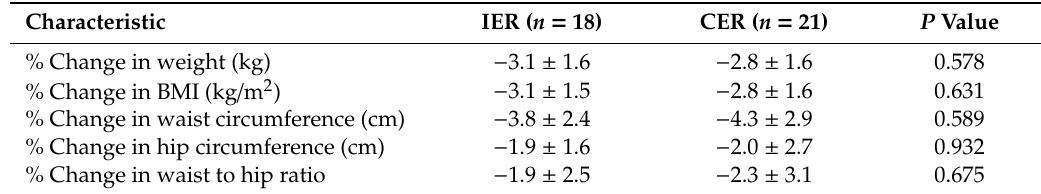
Table 2. Anthropometric measurements are all decreased after four weeks of energy restriction. There was no significant di ff erence in the percentage change in compliant participants between the groups in any anthropometric measure. Data is representative of both genders as a single cohort. The